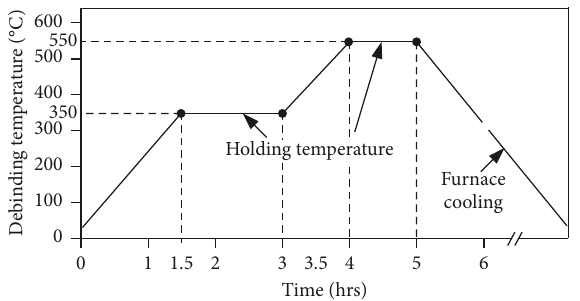
Figure 5: Temperature schedule for debinding process.